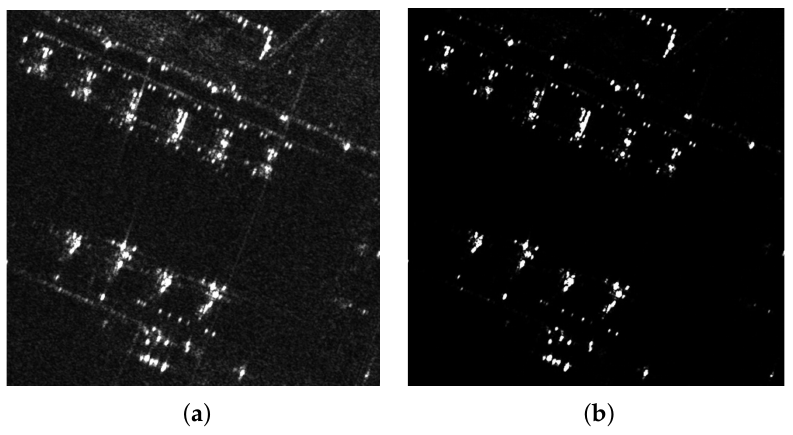
Figure 5. Enhanced salient points in a real SAR image. The left is a real SAR image and the right is the result after enhancing salient points. ( a ) Image example. ( b ) Salient